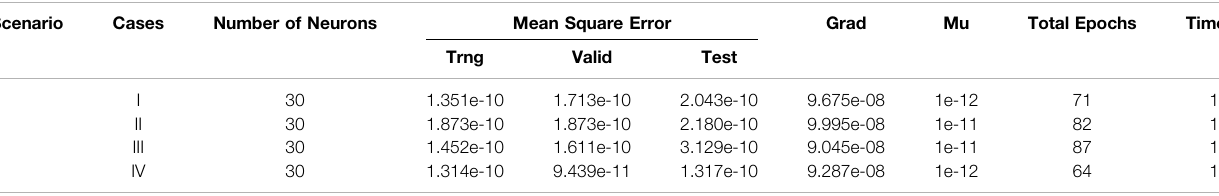
TABLE 4 | Numerical performance indicators for scenario I.